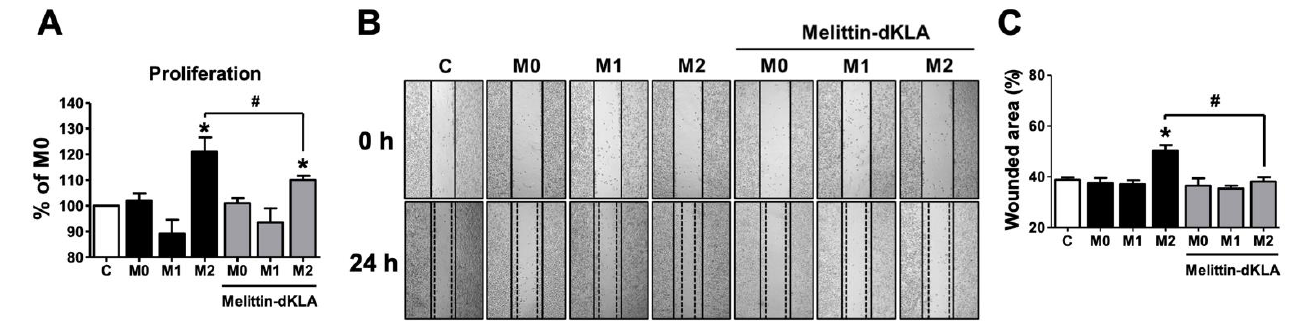
Figure 5. Proliferation and migration in SK-MEL-28 cells by conditioned medium of THP-1-derived M2 macrophages pretreated with melittin – dKLA. Human monocytes (THP-1) were treated with 100 nM PMA for 24 h and cultured with the following: 100 ng/mL LPS and 20 ng/mL rhIFN- γ for M1 macrophage differentiation; 20 ng/mL rhIL-4 and 20 ng/mL rhIL-13 for M2 macrophage differentiation. The differentiated macrophages were pretreated with melittin –dKLA (1 μM) for 1 h. For preparation of macrophages, macrophages were incubated with serum-free media for 24 h and then supernatants were harvested by syringe filter (0.2 μm). ( A ) Proliferation of SK-MEL-28 cells was measured by CCK-8 assay. ( B ) Migration of SK-MEL-28 cells was determined by wound healing assay. ( C ) The percent of each wounded area was calculated as: [(mean wounded breadth − mean remaining breadth)]/mean wounded breadth × 100. The graph presents the percentage of wounded area. All data are presented as means ± SD; * p < 0.05 versus the Control ( C ), # p < 0.05 versus the M2.